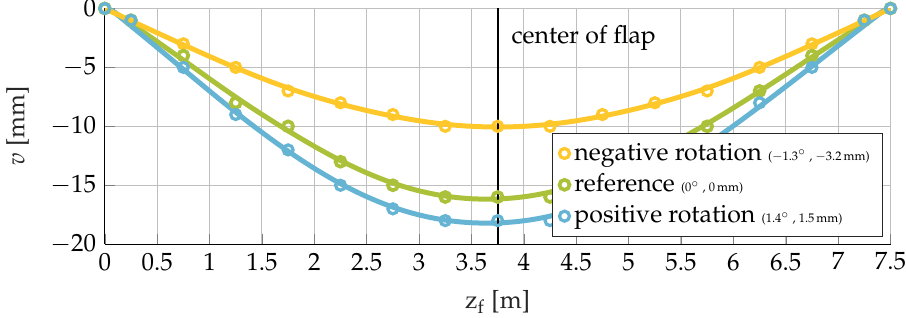
Figure 16. Deflection of flap with rotation around x-axis and translation in